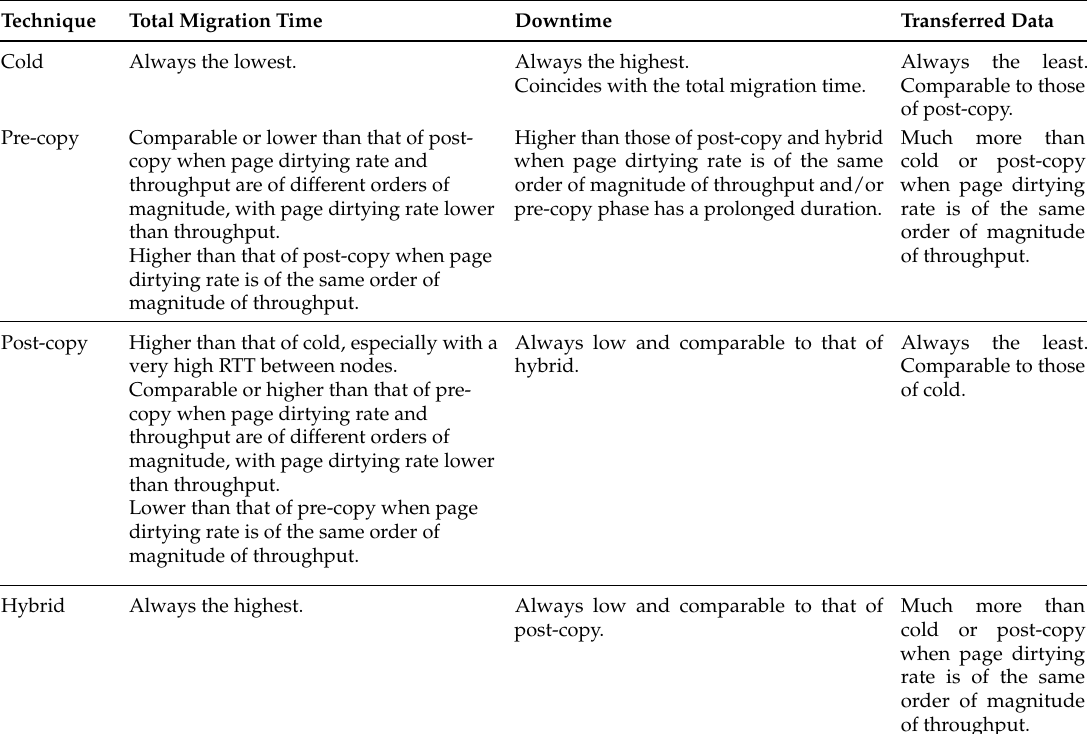
Table 4. Summary of the evaluated migration